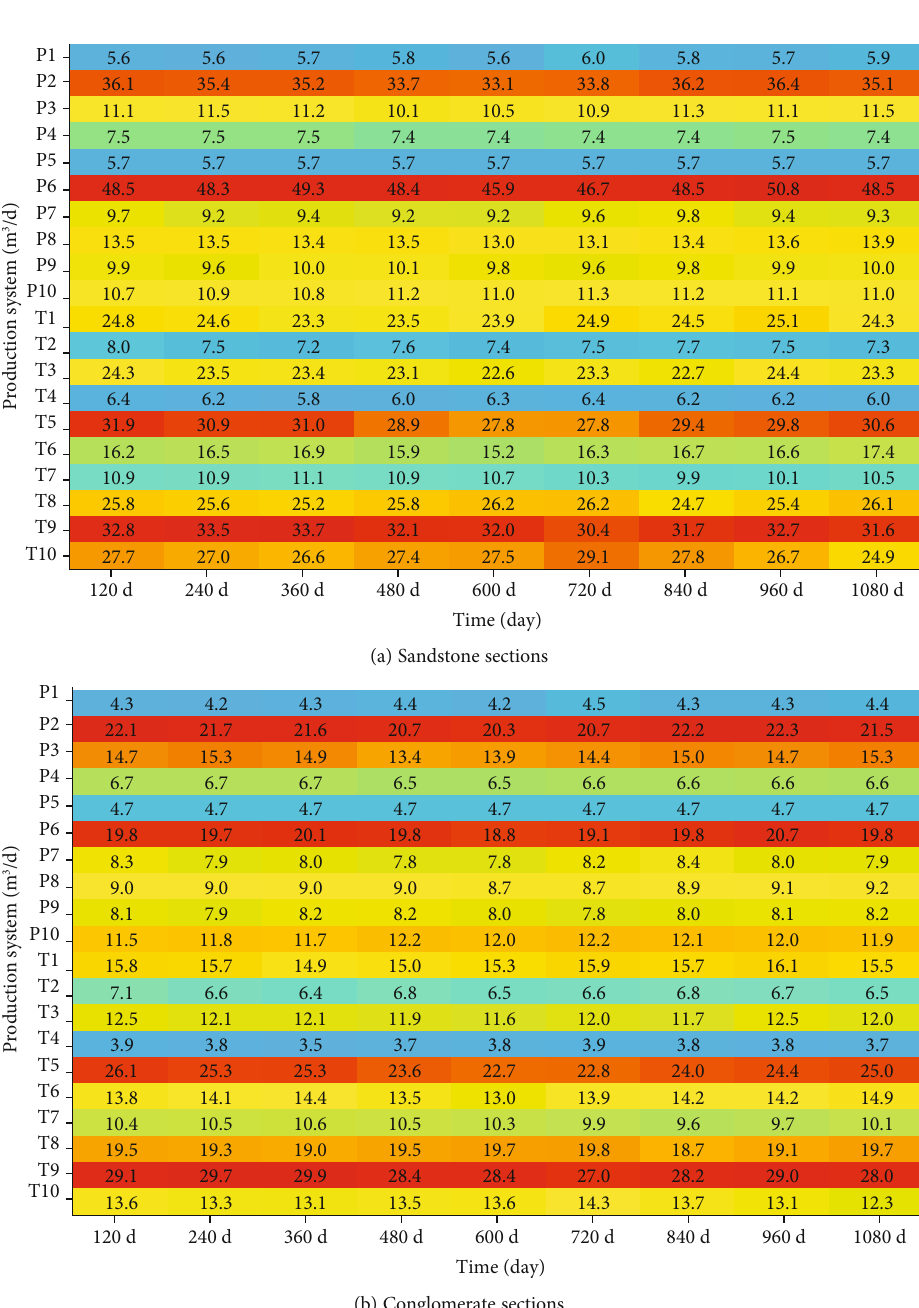
Figure 19: Adjusted production